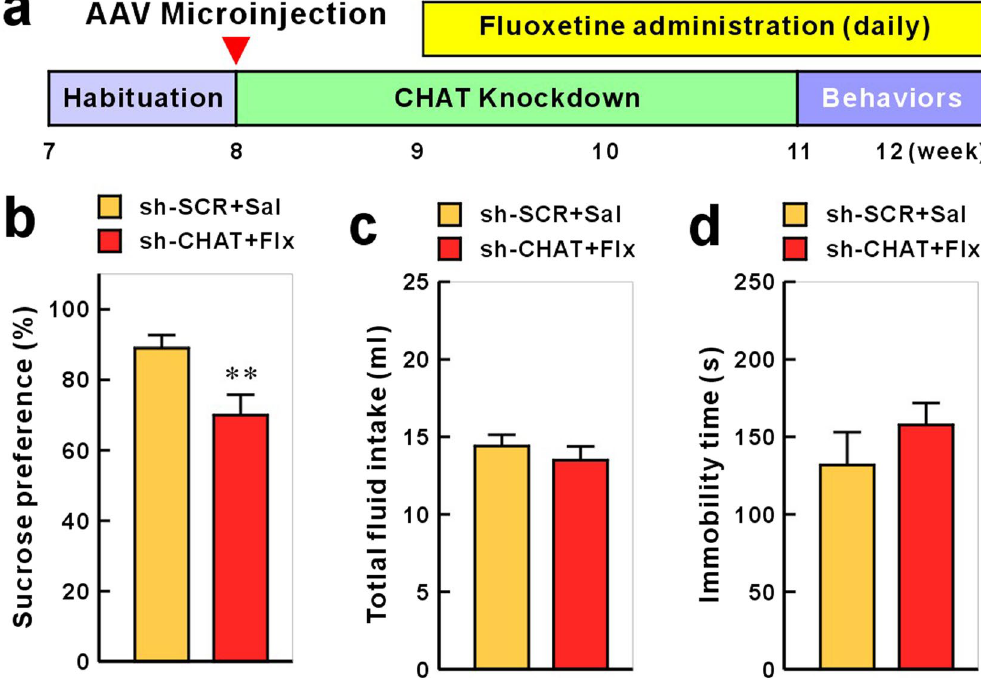
Figure 3. Fluoxetine does not reverse the anhedonia-like behavior induced by CHAT knockdown. ( a ) Rats were infused with AAV-sh-SCR or AAV-sh-CHAT and chronically treated with saline or fluoxetine (5 mg/kg) from one week after AAV infections throughout the experiment. Chronic administration of fluoxetine did not recover the effects of AAV-sh-CHAT infusion in the sucrose preference test ( b ), though no changes of total fluid consumption ( c ) or immobile time in the FST ( d ). Data represent mean ± SEM (sh-SCR + Sal, AAFV-sh- SCR + saline, n = 9 rats; sh-CHAT + Flx, AAV-sh-CHAT + fluoxetine, n = 15; ** P < 0.01, Student’s t